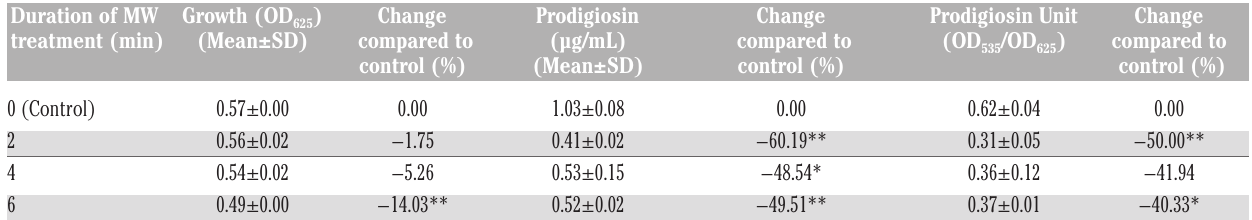
Table 3. Effect of low power microwaves (MW) on growth and prodigiosin production in S. marcescens. Duration of MW Growth (OD 625